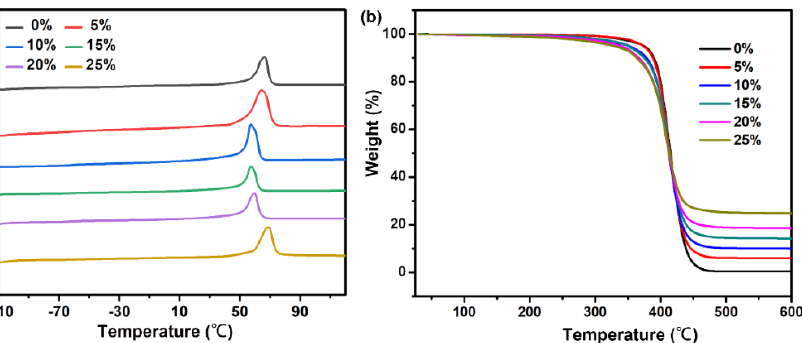
Figure 3. The thermal properties of the PCL/HA scaffolds with different HA contents. ( a ) DSC profiles for the PCL/HA scaffolds with different content of HA; ( b ) Thermogravimetric-differential thermal analysis curves of PCL/HA scaffolds.